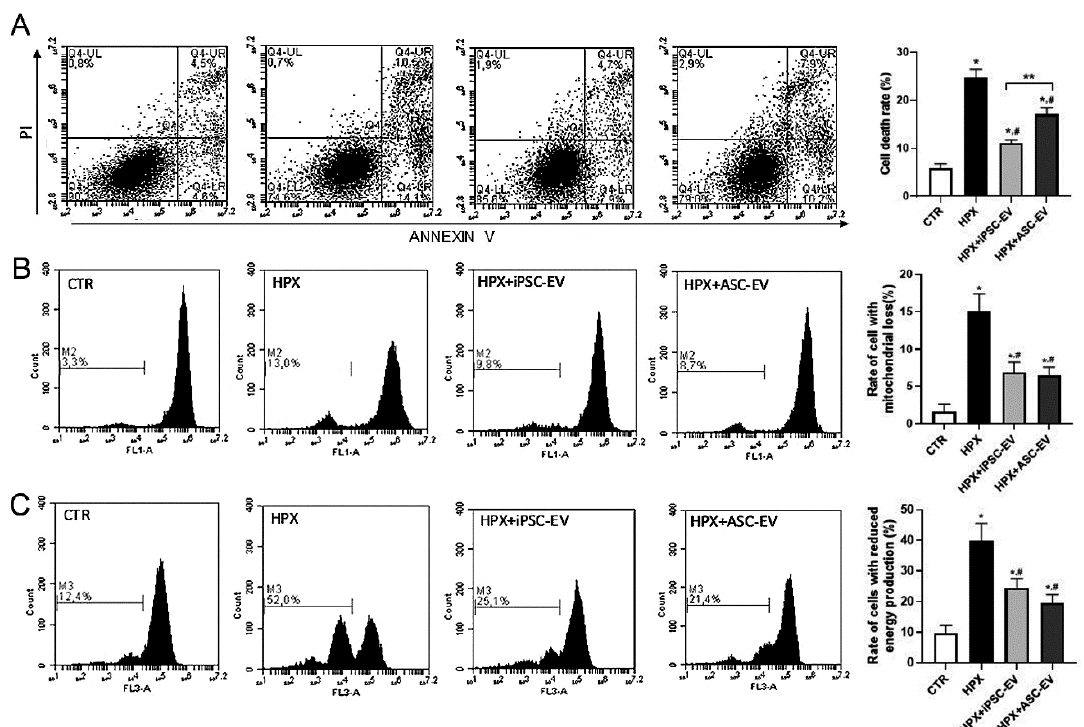
Figure 2. iPSC-EV reduced cell death and mitochondria damage in renal cells submitted to hypoxia-reoxygenation injury. ( A ) Representative flow cytometry analyses of renal cells stained for annexin V (ANX V) / propidium (PI) under the di ff erent experimental conditions. From left to right panels: CTR (cells cultured in normal condition), HPX (cells submitted hypoxia-reoxygenation injury), HPX + iPSC-EV (cells submitted to injury in the presence of iPSC-EV), and HPX + ASC-EV (cells submitted to injury in the presence of ASC-EV). The graph in the right shows the quantification of flow cytometry analyses in determining the rate of cell death of renal cells in all groups ( n = 5). ( B ) Analyses of alterations in renal cells’ mitochondria mass. The panels are representative flow cytometry analyses of renal cells incubated with the mitochondria fluorescent marker MitoTracker Green FM. The abscissa indicates the distribution of fluorescence intensity given by the respective mitochondria mass in treated cells. The ordinate indicates the number of events analyzed. M2 indicates the percentage of cells with reduced fluorescence intensity and, therefore, reduction in mitochondria mass. The graph in the right shows the percentage of the total cell population that presented a reduction of mitochondria mass, as indicated in the ordinate. The experimental group conditions are indicated in the abscissa ( n = 5). ( C ) Analyses of alterations in renal cells’ mitochondria potential ( ∆Ψ m). The panels are representative flow cytometry analyses of renal cells incubated with the mitochondria fluorescent marker MitoTracker Orange CMTMRos. The abscissa indicates the distribution of fluorescence intensity given by the respective mitochondria with intact ∆Ψ m. The ordinate indicates the number of events analyzed. M3 indicates the percentage of cells with reduced fluorescence intensity and, therefore, reduction in mitochondrial ∆Ψ m. The graph in the right shows the percentage of the total cell population that presented a reduction of mitochondria mass with intact ∆Ψ m, as indicated in the ordinate. The experimental group conditions are indicated in the abscissa ( n = 5). Data represent mean ± SEM (* indicates statistical di ff erence to CTR group; # indicates statistical di ff erence to HPX group; ** indicates statistical di ff erence to HPX + iPSC-EV group; p < 0.05 assessed by one-way ANOVA followed by Tukey’s test).